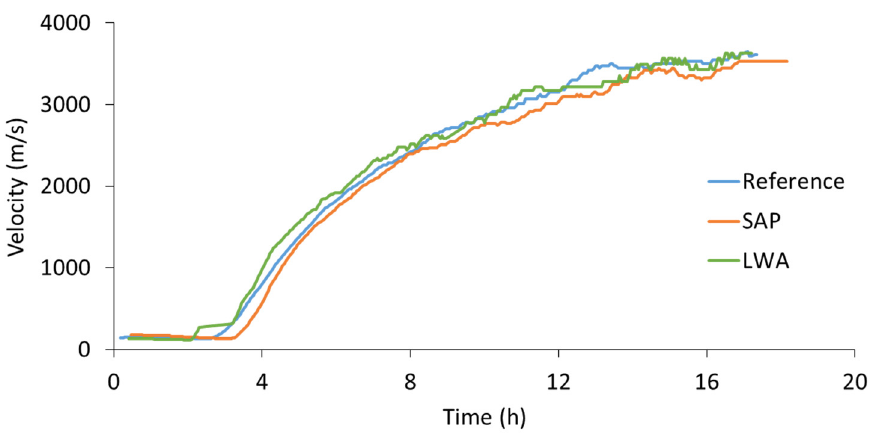
Figure 8. Velocity vs. time of reference, SAP and LWA mortar.